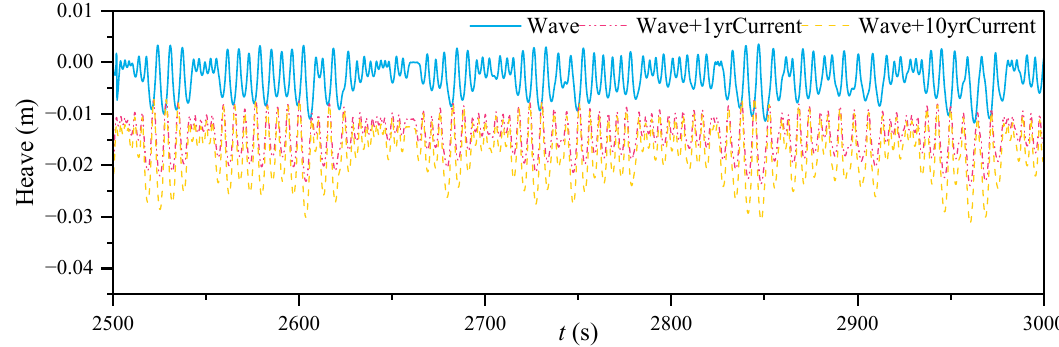
Figure 18. Pitch response under wave load and wind load.